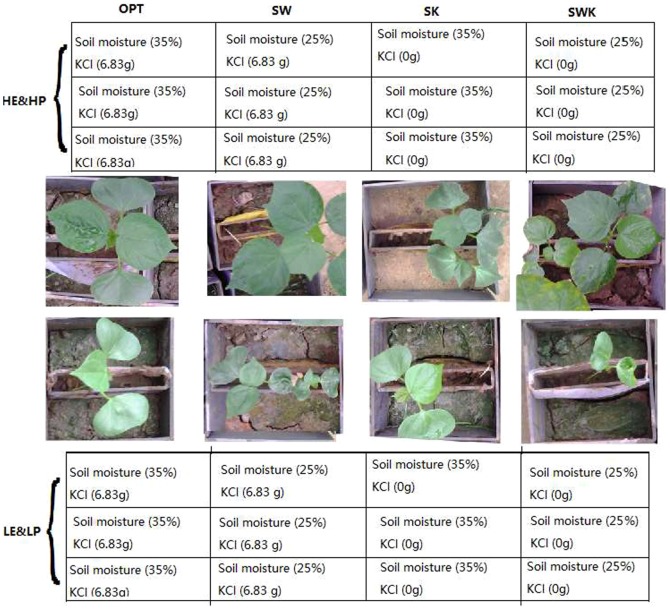
Diagram of experimental design to evaluate status changes of soil potassium.